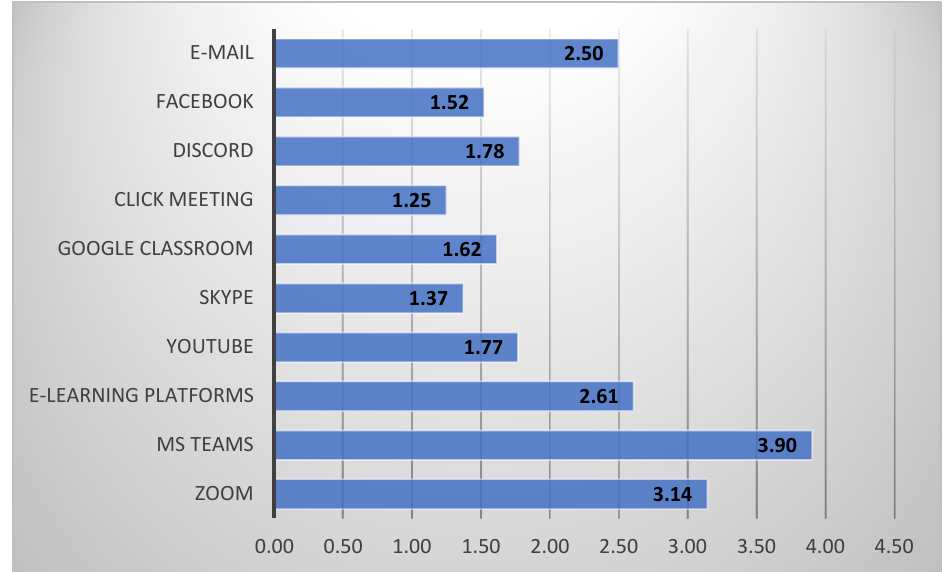
Figure 4. Assessment of the frequency of using e-learning tools during classes.